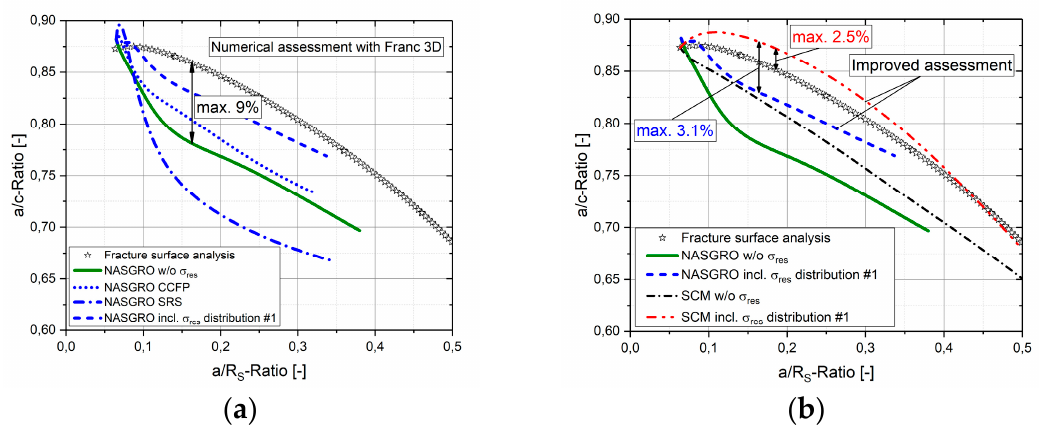
Figure 16. ( a ) Crack shape evolution of numerical computations with Franc3D; ( b ) Comparison of SCM model (analytically by INARA) and NASGRO model (numerically by Franc3D) to the experimental fit.